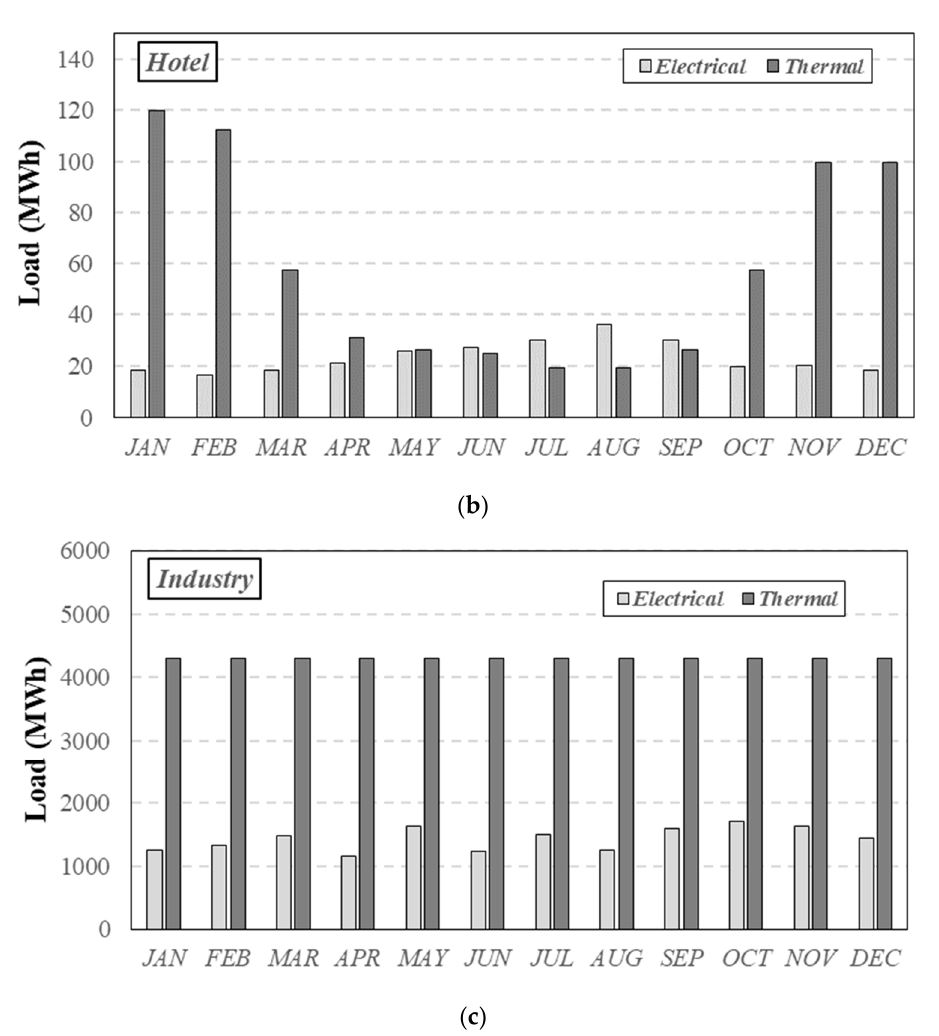
Figure 3. Electrical and thermal loads of the three users defined: ( a ) house; ( b ) hotel; and ( c ) industry.